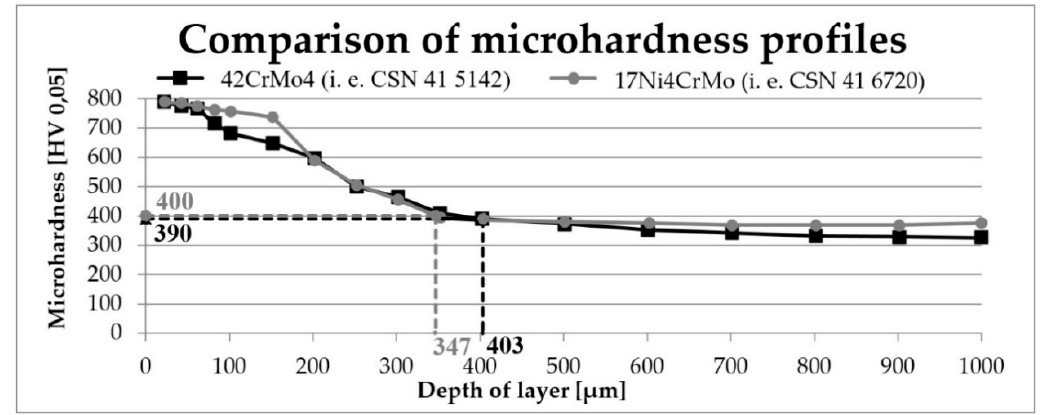
Figure 3. Comparison of microhardness profiles of the steels after application of plasma nitriding.